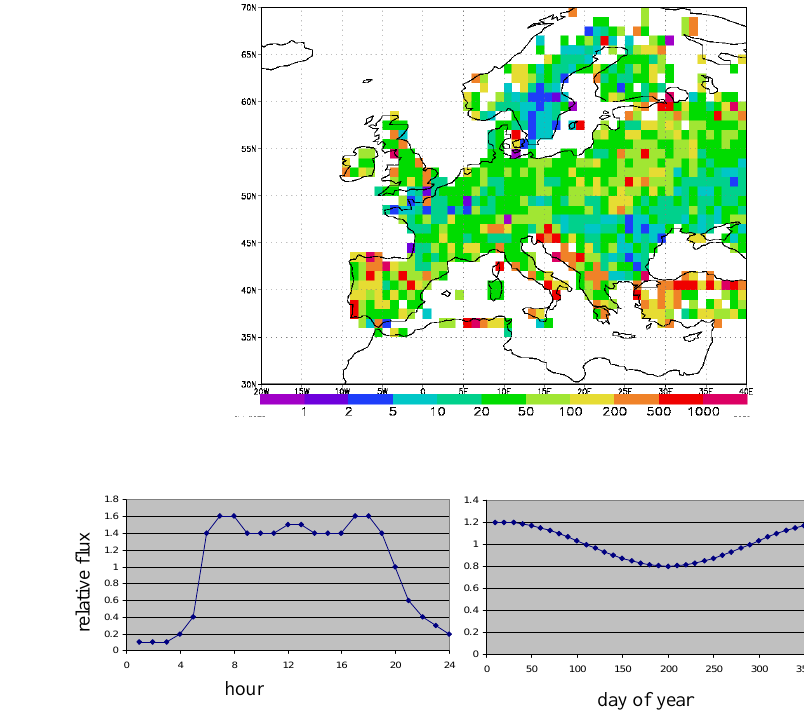
Fig. 6. (a) Anthropogenic CO 2 flux (terrestrial only) in µmolm − 2 s − 1 from EDGAR database version 3.2, (b) Temporal disaggregation of these emissions: mobile emissions (left) vary diurnally, non-mobile emissions (right) vary seasonally. Note that the emission is per m 2 urban area per